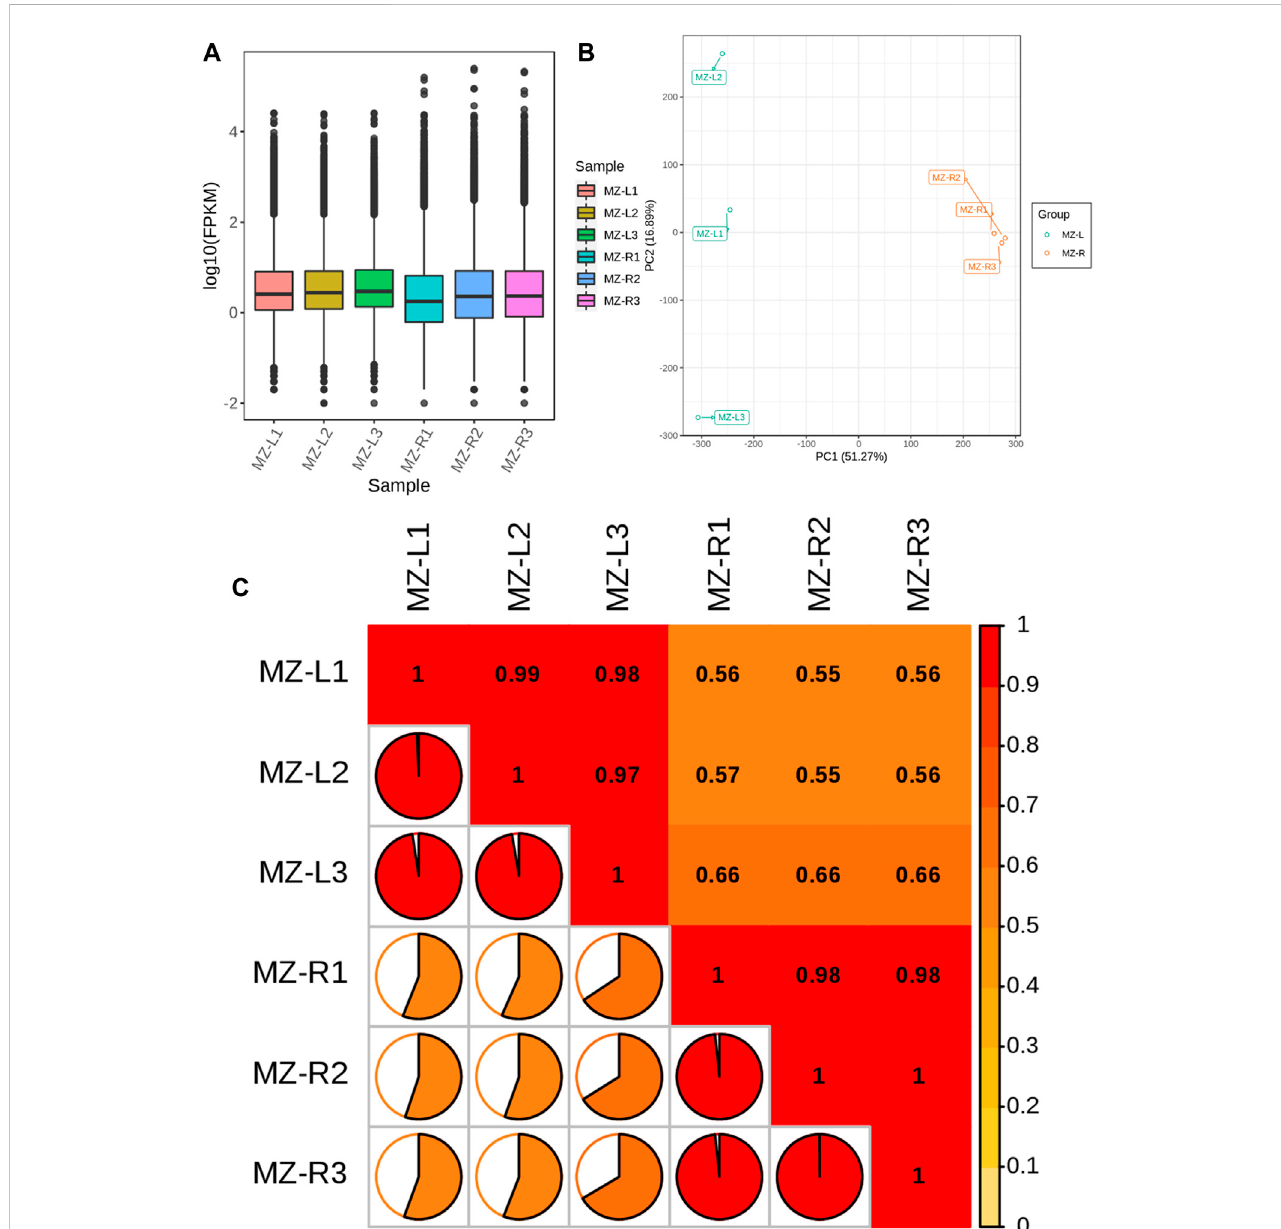
FIGURE 1 Demonstration of quality control of transcript data as (A) boxplots illustrating the overall fragment/kb of transcript/million mapped reads (FPKM) values for replicated samples. The abscissa depicts different samples of leaves and roots; the ordinate illustrates each sample expression ’ s log 2 values for FPKM. (B) Principal component analysis (PCA) of the samples regarding their gene expression. The green color represents leaf samples, whereas the orange color depictsrootsamples. (C) Thecorrelationmatrix revealsPearson ’ scorrelationcoef fi cient(PCC) geneexpression fromtriplicated V.mengtzeanum leaves and root samples. The color gradient from yellow to red represents the range of correlation values from 0 to